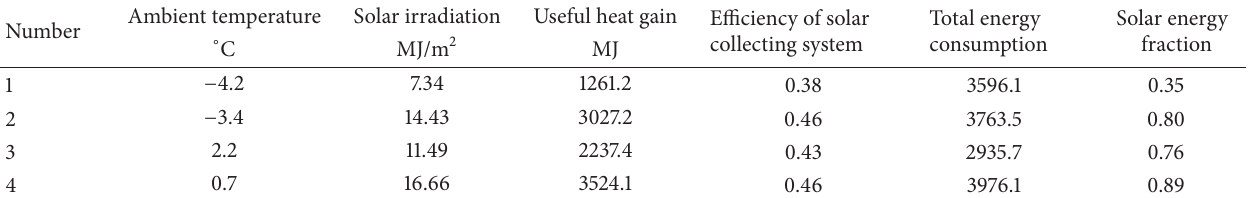
Table 14: Test results for a solar air-conditioning system during heating